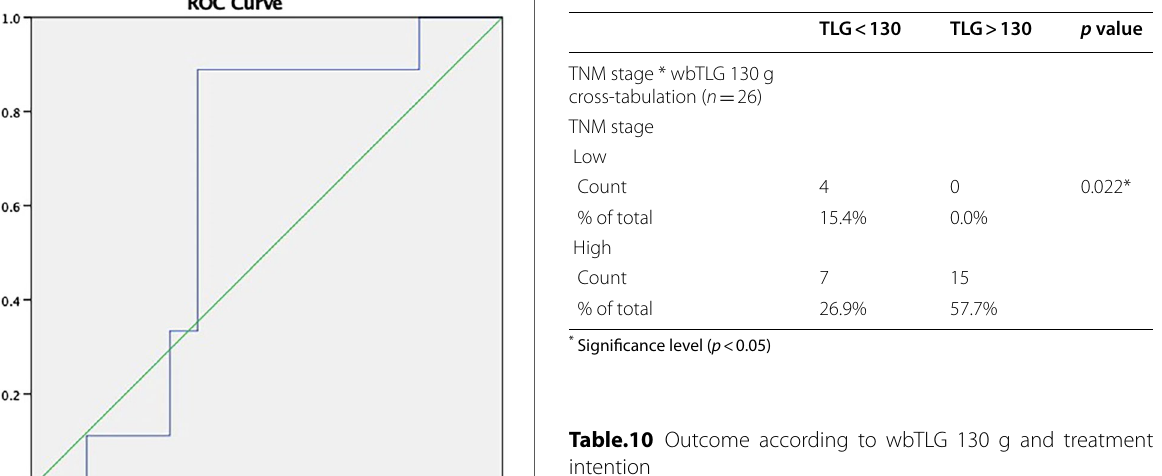
Table.9 Outcome according to wbTLG 130 g and TNM stage